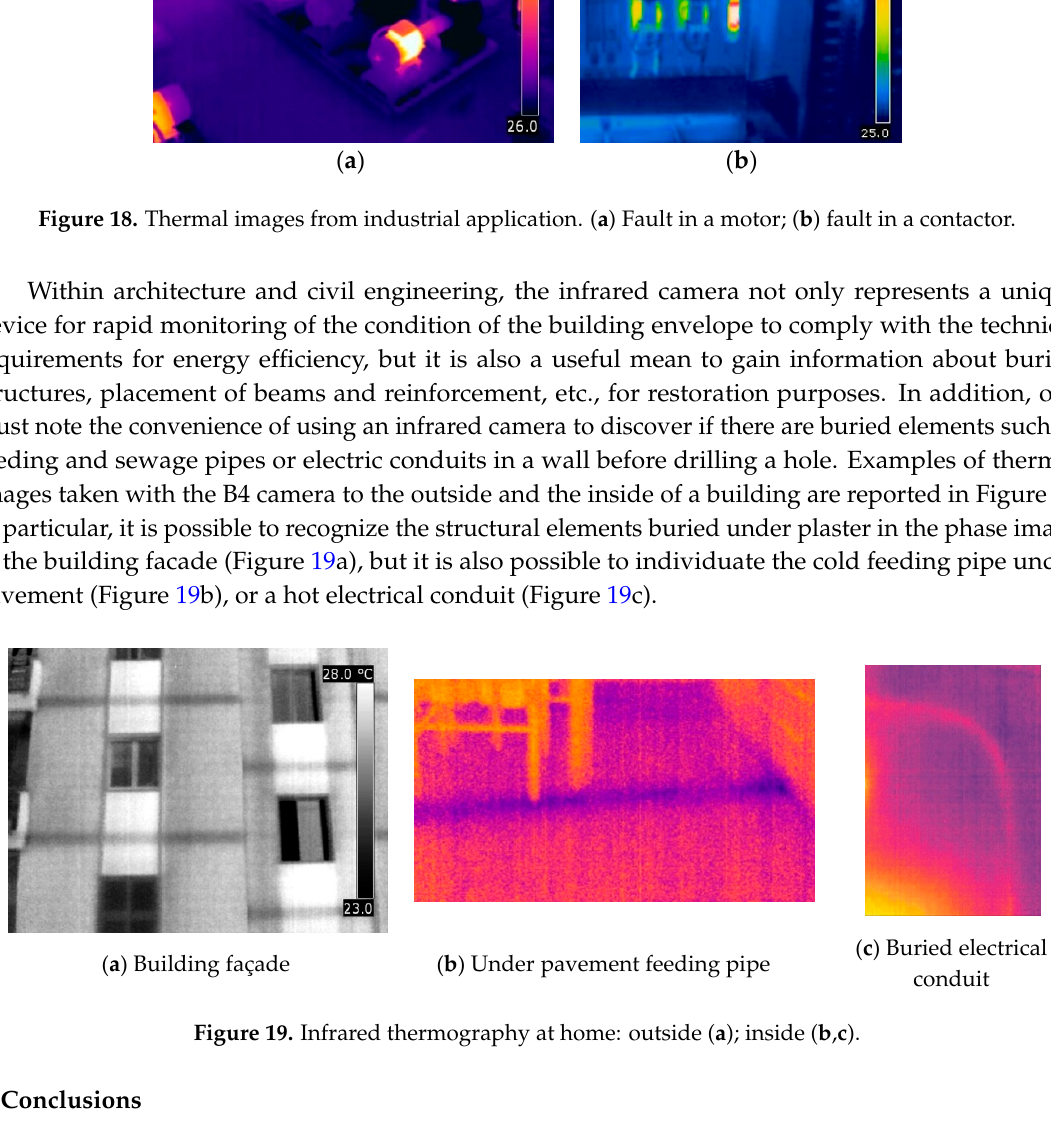
Figure 19. Infrared thermography at home: outside ( a ); inside ( b , c ).